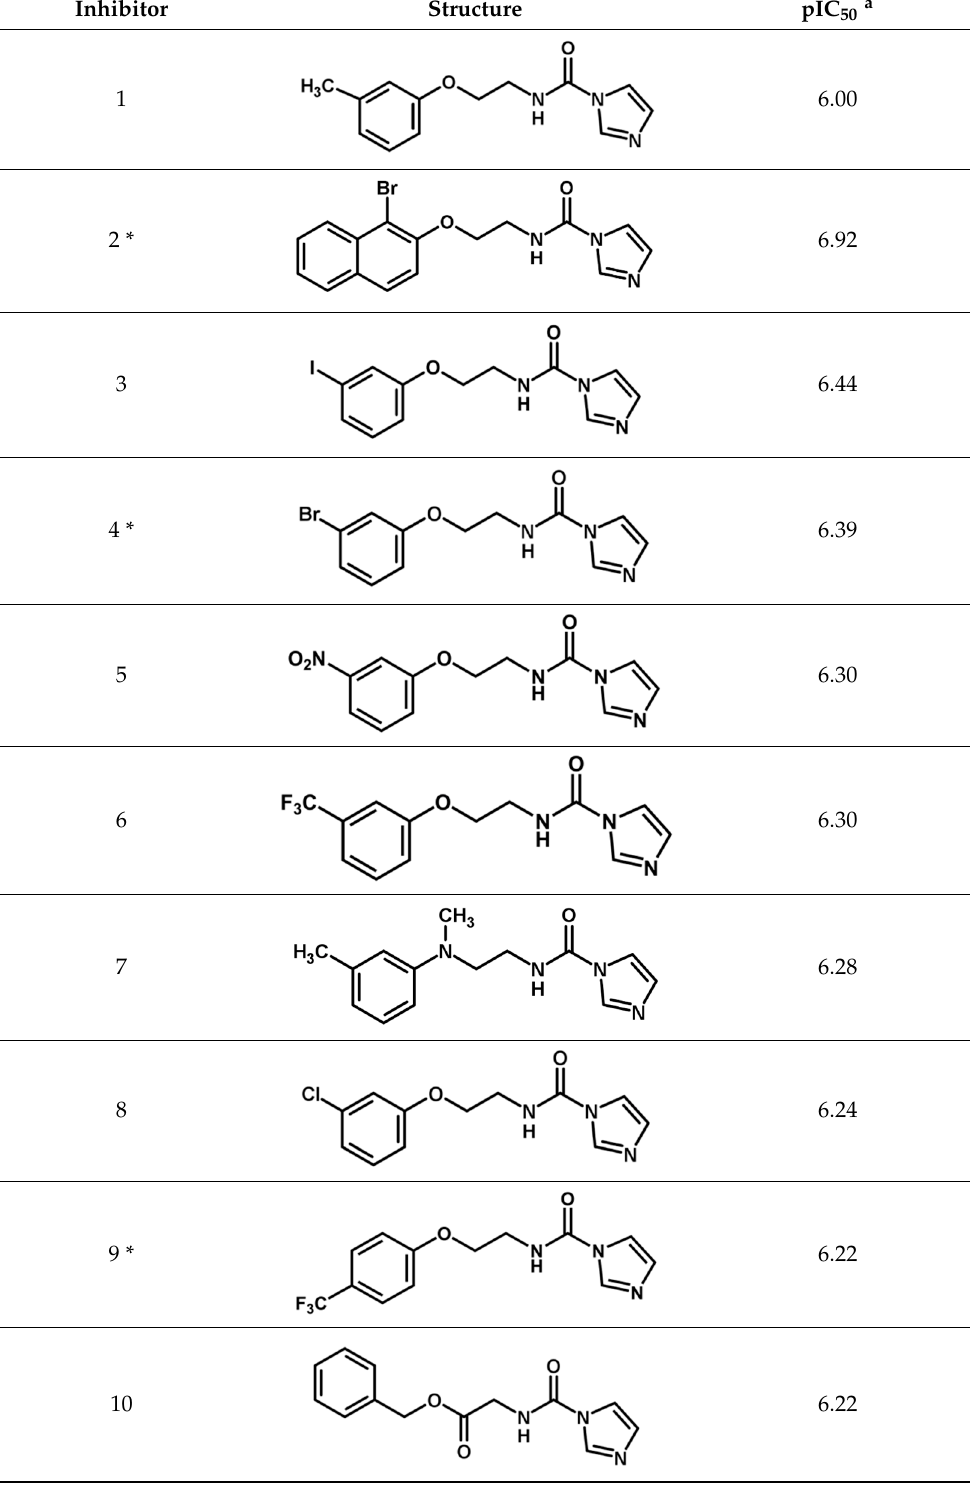
Table 1. Structure of the dataset compounds and pIC 50 values.